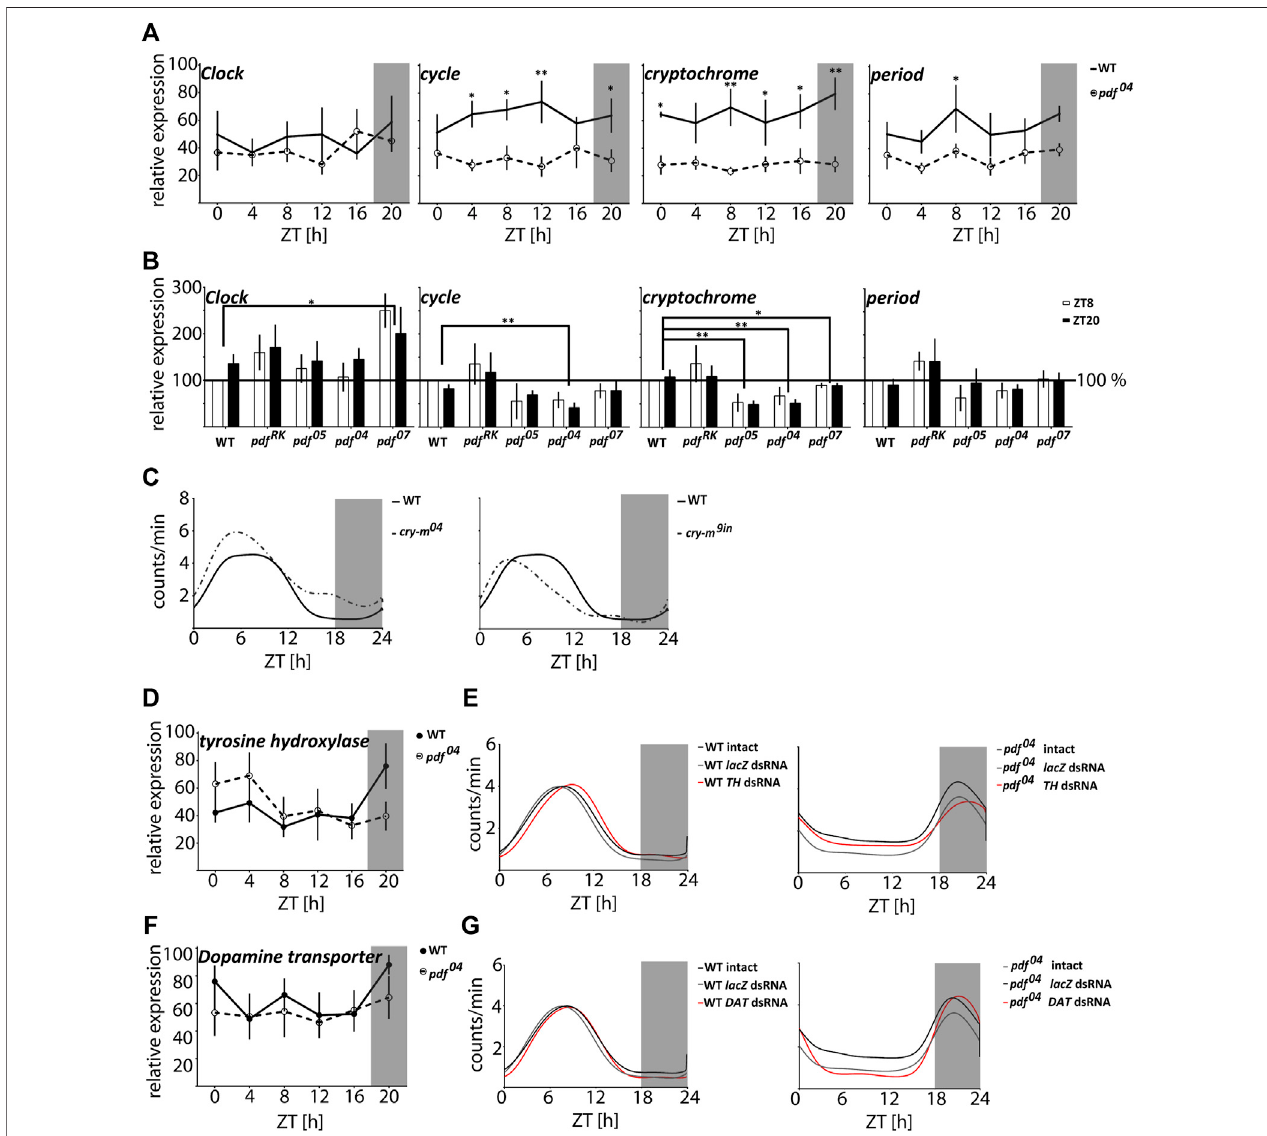
FIGURE 4 | The nocturnal activity of pdf null mutants is independent of either the circadian clock or dopamine signaling. (A) Circadian clock gene expression in headsofWT(fullcircles, solidline)and pdf 04 − / − mutantmales(emptycircles,dashed line)throughouttheday ( n =4independentrepeats, errorbar±SEM). (B) Circadian clock gene expression in heads of WT and pdf mutant males at ZT8 and ZT20 ( n = 5independent repeats, error bar ± SEM). Statistical differences are marked by (*) p < 0.05, (**) p < 0.01, (***) p < 0.001 (C) The smoothed average locomotor activity of cry-m 04 − / − and cry-m 9in − / − males in LD 18:6 cycles. (D) Expression of tyrosine hydroxylase (TH) in heads ofWT (full circles, solid line) and pdf 04 − / − mutantmales (empty circles, dashed line) throughout the day ( n = 4 independentrepeats, error bar ± SEM). (E) The smoothed locomotor activity of intact, lacZ lacZ dsRNA and TH dsRNA treated WT (on the left) and pdf 04 − / − males (on the right). (F) Expression of Dopaminetransporter(DAT)in headsofWT (fullcircles, solid line)and pdf 04 − / − mutant males (emptycircles,dashed line)throughout theday ( n =4independent repeats, error bar ± SEM). (G) The smoothed locomotor activity of intact, lacZ dsRNA and DAT dsRNA treated WT (on the left) and pdf 04 − / − males (on the right). Graphs represents the average activity of all bugs scored as “ rhythmic in LD. ” Grey rectangles on graphs depict